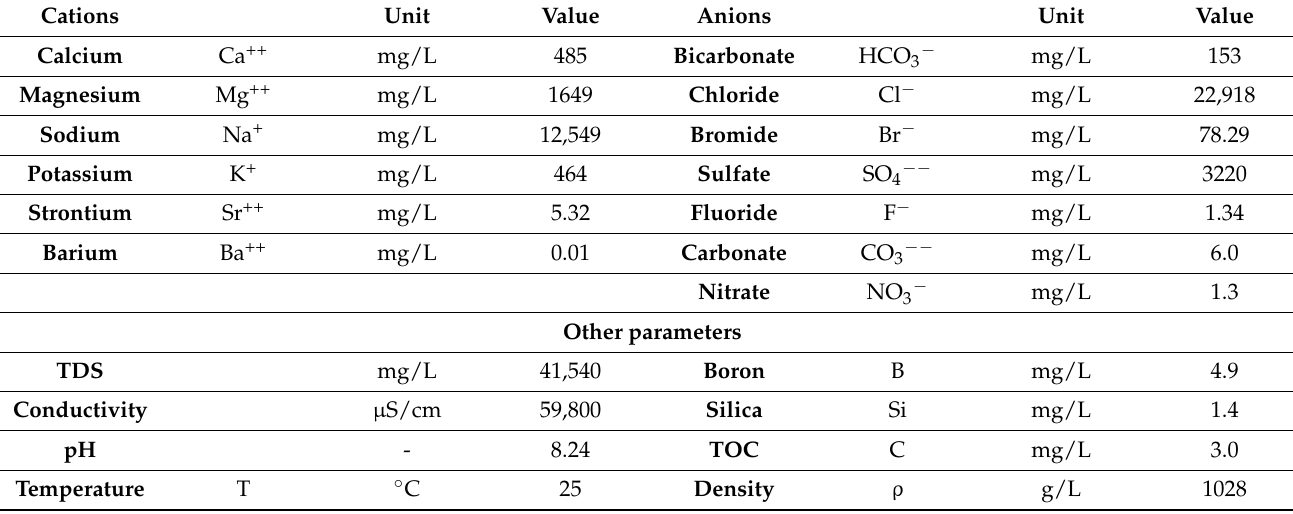
Table 1. Elemental composition of seawater used for the pilot